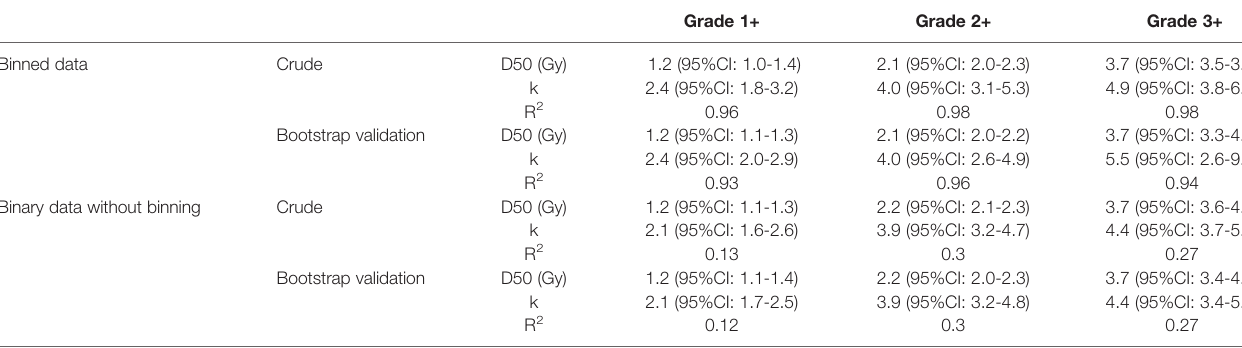
TABLE 2 | Parameters in NTCP